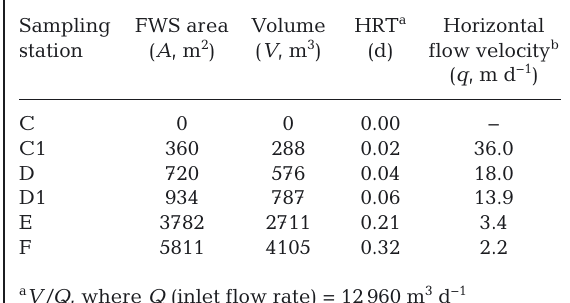
Table 1. Wetland sampling stations cf. Fig. 1 positioned at increasing hydraulic retention time (HRT). FWS: free water